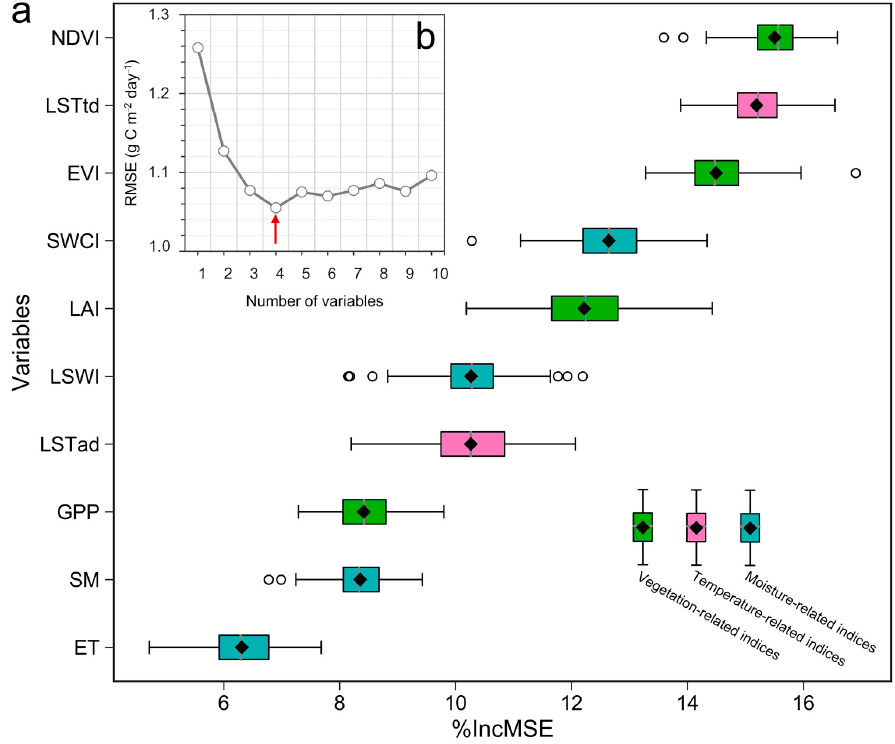
Figure 6. Importance ranking of the input variables measured with % IncMSE from 100 repeated runs of the RF model (500 Ntree and 4 Mtry) ( a ). The insert figure ( b ) denotes the selection of the optimal variables by using the backward elimination searching method [75,77], and the RMSE is calculated based on the 10-folds cross-validation (CV) method.